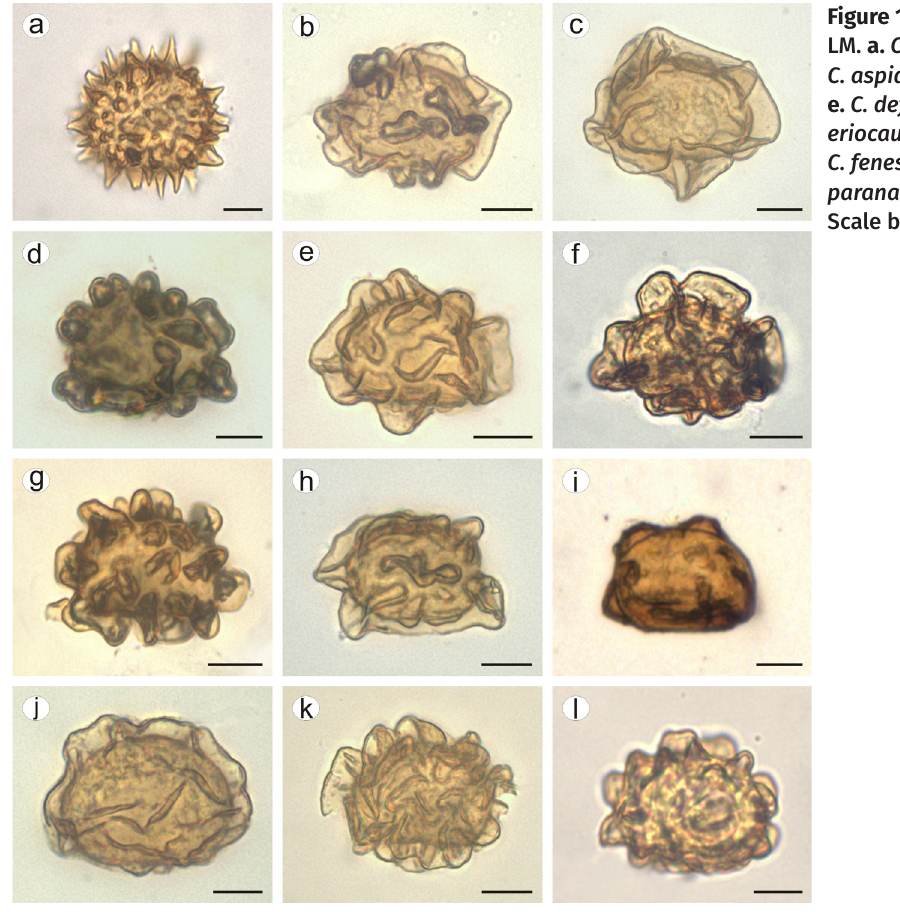
Figure 1. Spores of Ctenitis